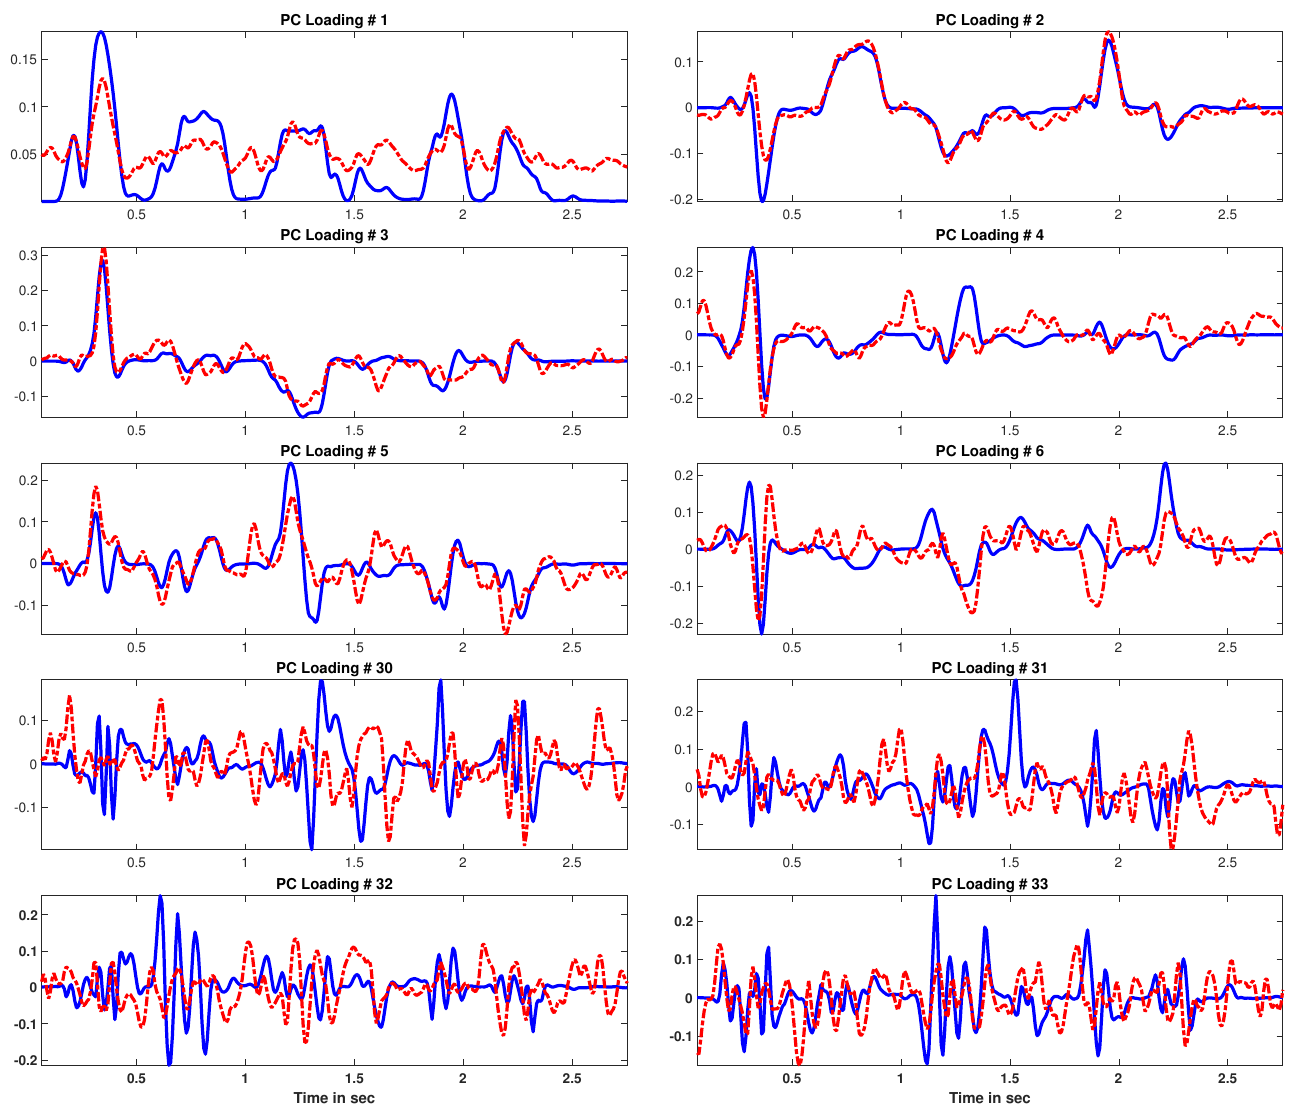
Figure 4. The PC loadings of the STFTs of clean (in solid blue) and noisy (in dash-dotted red) signals. Here, we would like to highlight two key issues with the aforementioned framework (i.e., PCA performed over the entire signal STFT). Firstly, in the signal under consideration, the noise component is present for the entire signal duration (see Figure 1c), whereas the signal of interest, the speech signal, contains periods of silence corresponding to almost 20–30% of the entire signal duration (see Figure 1a). Therefore, we can expect that the PCA computation might get biased towards learning such PCs and PC loadings, which can explain the entire duration of the signal. This is indeed the case, as this effect is clearly visible in PC 1 in Figure 3 and PC loading 1 in Figure 4. The first PC loading from the clean STFT (blue) clearly shows that the corresponding PC component has been able to capture the signal variance during the time periods of voice activity. This, however, is not the case with the first components learned from the noisy STFT, where these estimated components have ended up capturing a significant noise contribution as well. Secondly, if at anytime during the signal recording, the energy of a few noisy frequen- cies gets higher than usual, then the PC and PC loading entries corresponding to these frequencies will become large (i.e., the corresponding singular value will get large). As a result, these otherwise noisy components might get picked up for the STFT approximation, leading to a reduction in the effectiveness of the noise